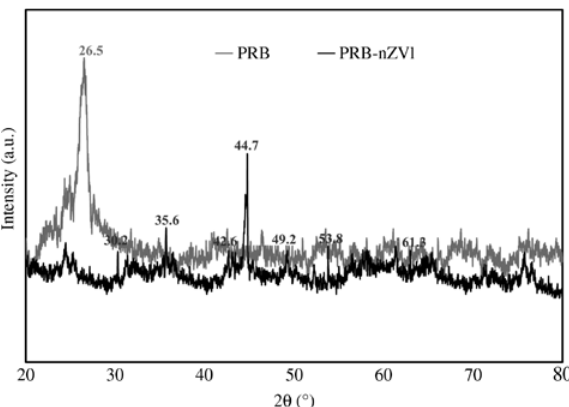
Figure 2: XRD patterns of a PRB and